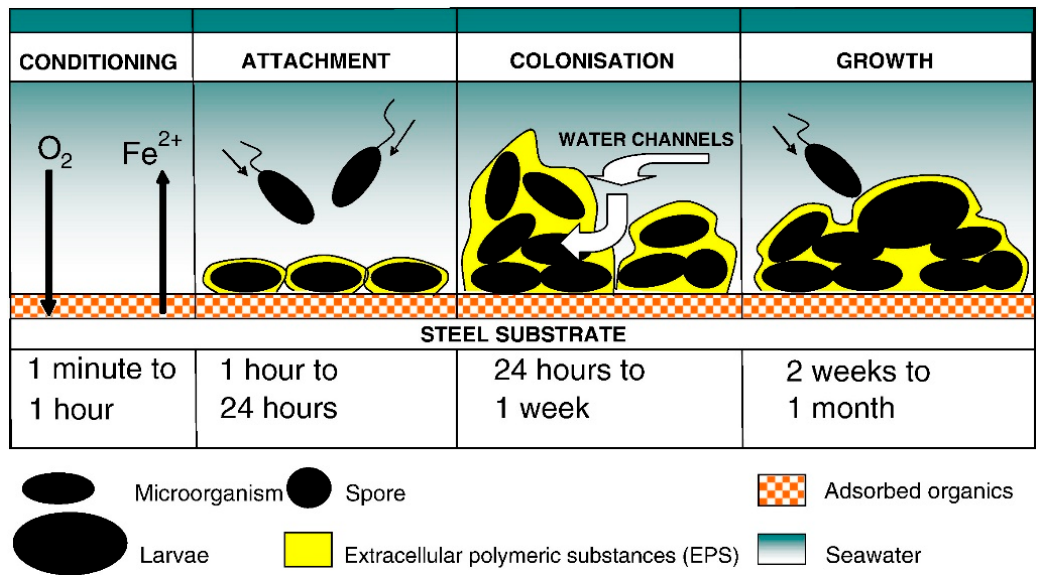
Figure 1. Illustration representing the stages of biofouling formation. Each of the stages shown can occur in the indicated order individually, in parallel or all at the same time [21].